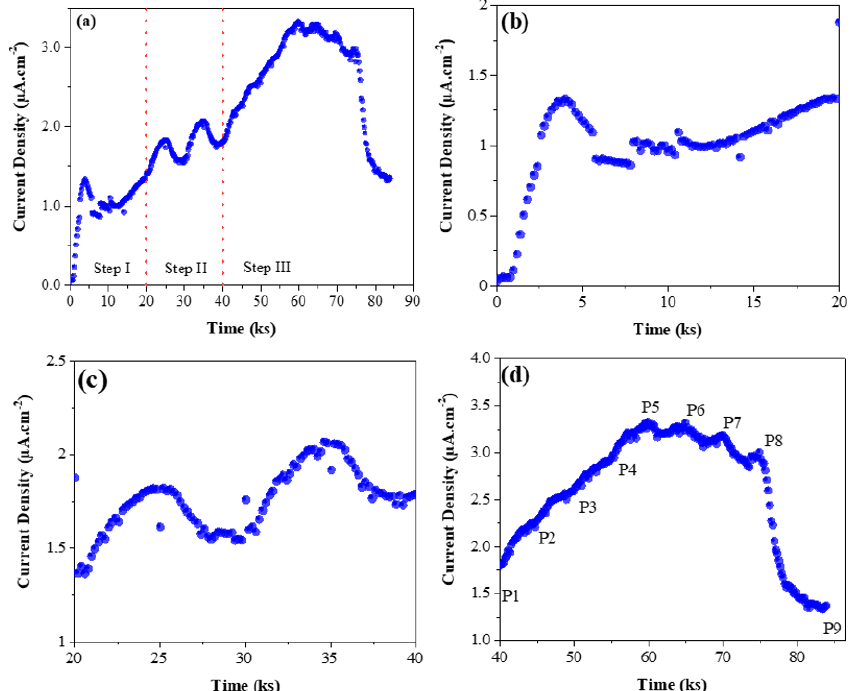
Figure 2. ( a ) The complete data of three-step permeation experiment involving pre-charging, successive partial transient, and partial transient loop at different charging current densities for CP1000. Expanded plots of ( b ) the pre-charging step; ( c ) the successive partial transient; ( d ) partial transient loop for CP1000. Each point in the figure ( d ) corresponds to the applied current density at the charging surface during the test (P1: − 10 mA · cm − 2 ; P2: − 20 mA · cm − 2 ; P3: − 30 mA · cm − 2 ; P4: − 40 mA · cm − 2 ; P5: − 50 mA · cm − 2 ; P6: − 40 mA · cm − 2 ; P7: − 30 mA · cm − 2 ; P8: − 20 mA · cm − 2 ; P9: − 10 mA · cm − 2 ).